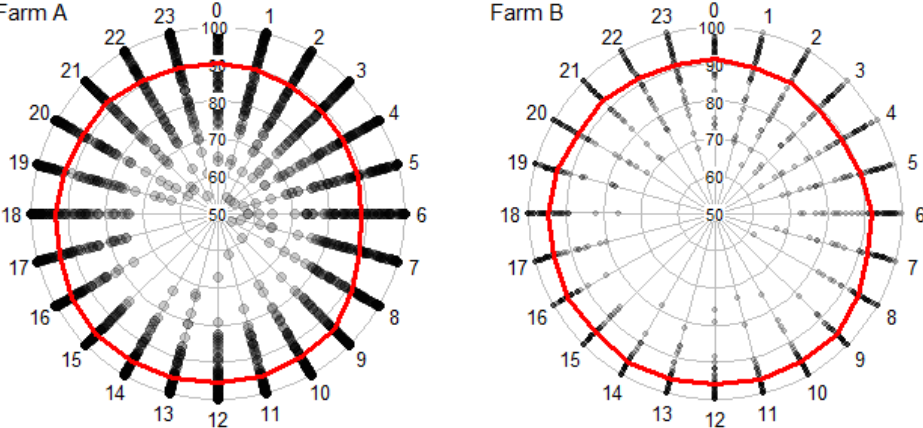
Figure 2. Percentage of ewes outdoors dependent on time of day. One point corresponds to one photograph and the red line indicates the mean percentage of ewes outside.